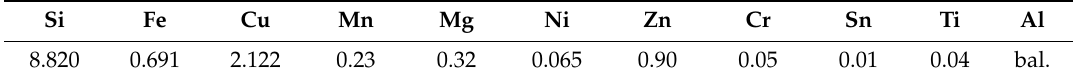
Table 1. Chemical composition of the experimental AlSi 9 Cu 3 (Fe) alloy (wt.%). Si Fe Cu Mn Mg Ni